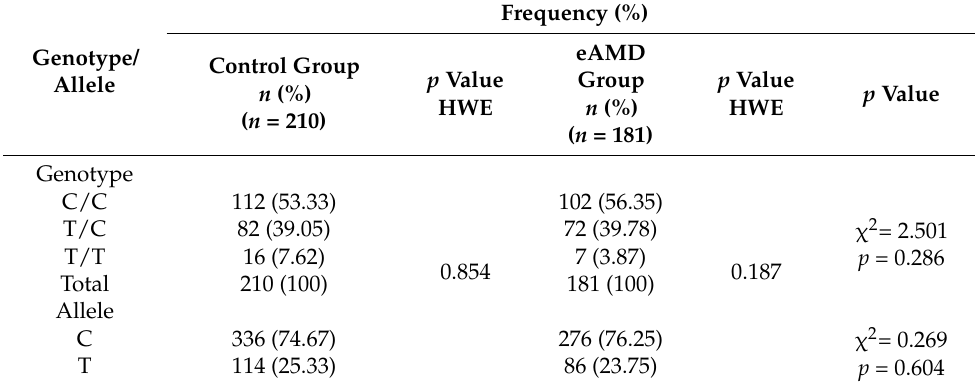
Table 2. Frequency of the CYP4F2 rs2108622 genotypes in the eAMD and control groups.